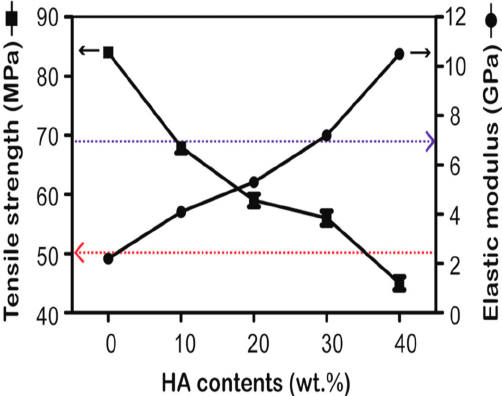
Figure 11. Tensile strength and elastic modulus vs filler content of the PEEK-mHA composites. The blue dotted line denotes low modulus limit of cortical bone (7 GPa). The red dotted line indicates the low tensile strength range of cortical bone (50 MPa). Reproduced from [135] with permission of BioMed Central under the terms of the Creative Commons Attribution 4.0 International